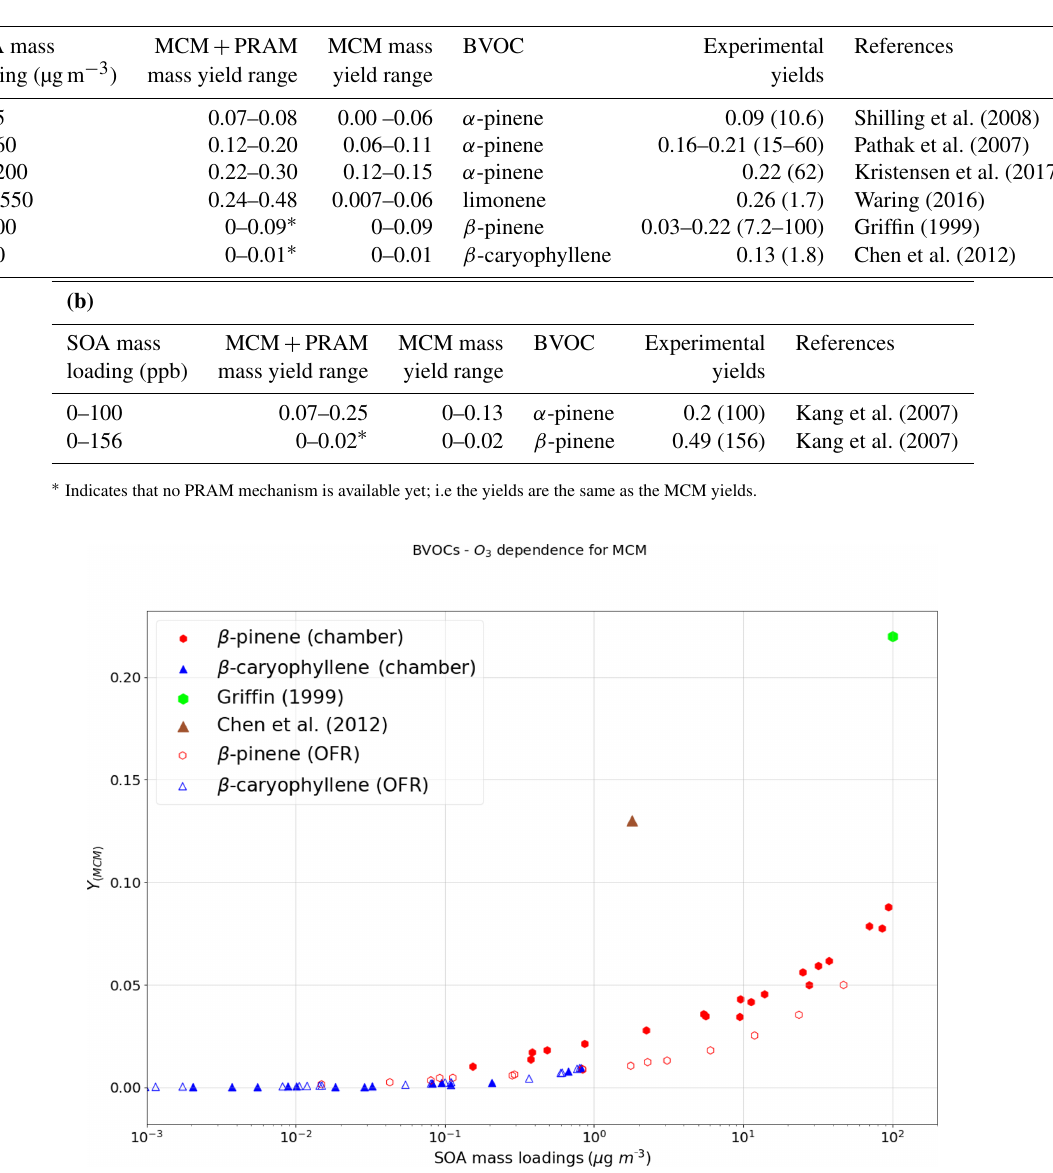
Figure 2. The mass yields from the ozonolysis of BVOCs β -pinene and β -caryophyllene modeled after chamber (filled symbols) and flow- tube (open symbols) settings. The figure shows a comparison of SOA mass yields obtained from simulations with only MCM as currently there is no PRAM available for these compounds. The experimental values are provided for